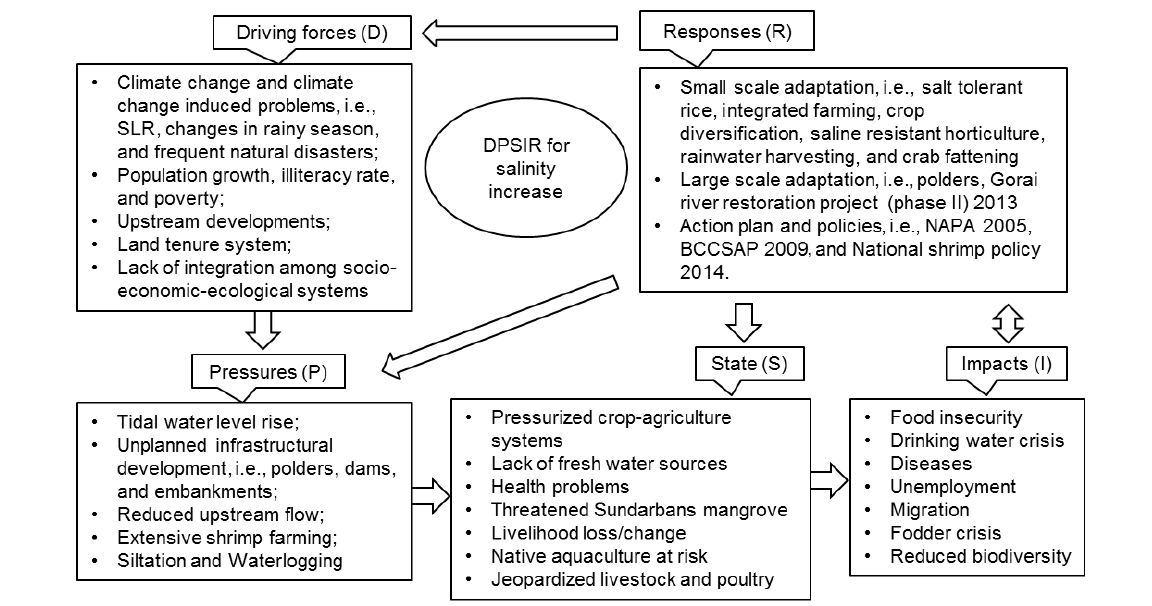
Fig. 6 . Interaction between society and coastal systems. (Here, SLR denotes sea-level rise; DPSIR: driver- pressure-state-impact-response; NAPA: National Adaptation Programme of Action; and BCCSAP: Bangladesh Climate Change Strategy and Action